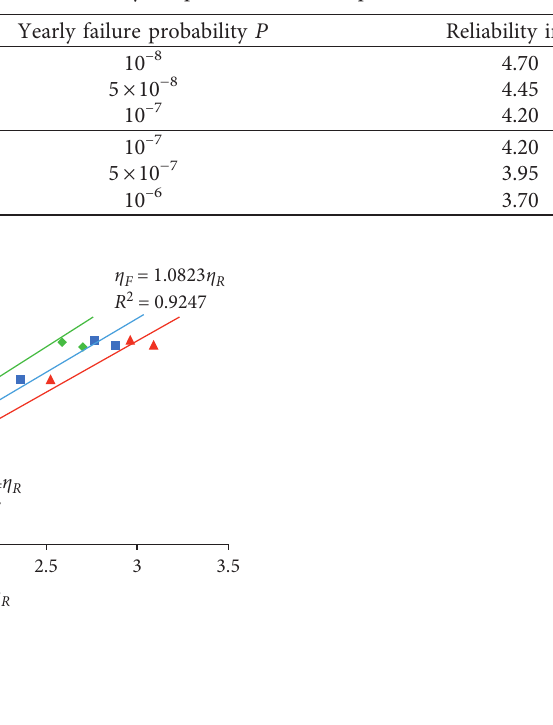
− η R F of the slope of the Nuozhadu hydropower station for different safety standards (special class I dam